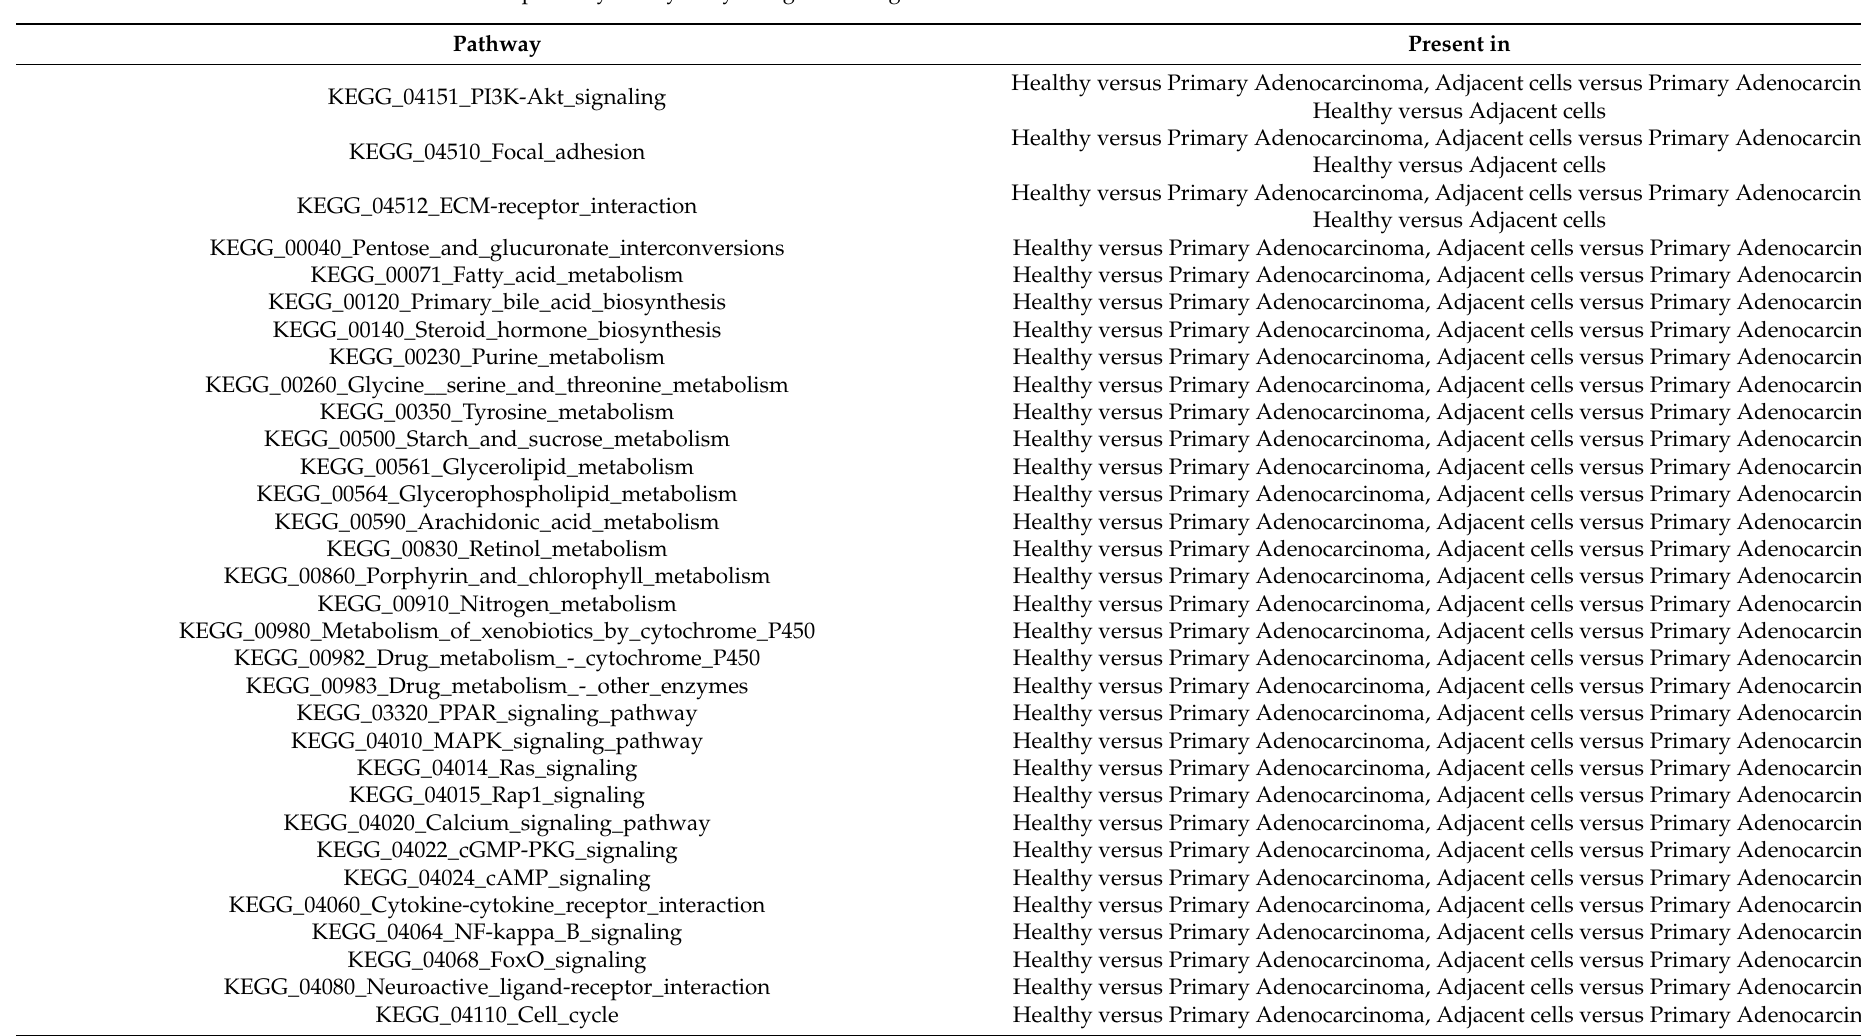
Table 1. Enriched pathways analysis by using Venn